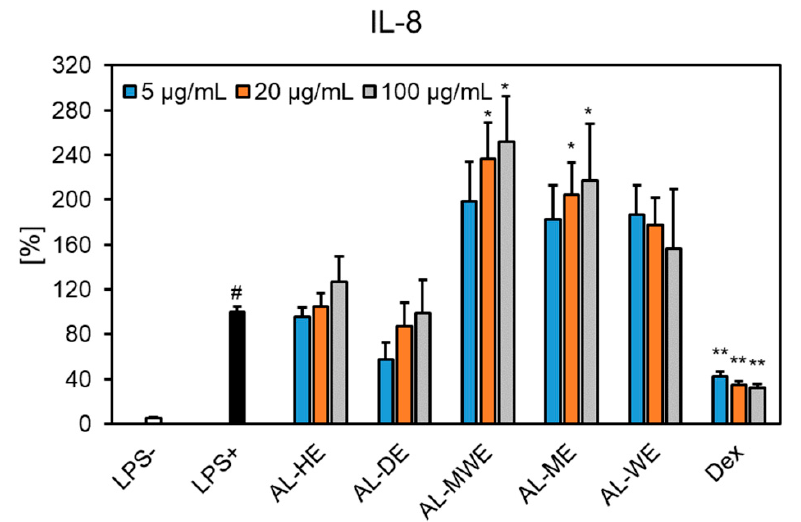
Figure 10. The effects of Artemisia campestris subsp. lednicensis extracts (5–100 µ g/mL) and dexamethasone (Dex) (0.01–1 µ M) on IL-8 production in LPS-stimulated (100 ng/mL) neutrophils. Results are presented as the mean ± SEM of three separate experiments performed with cells isolated from six independent donors; # p < 0.001 vs. non-stimulated control (LPS-); * p < 0.05; ** p < 0.001 vs. stimulated control (LPS+). Abbreviations: AL-HE, A. campestris subsp. lednicensis hexane extract; AL-DE, A. campestris subsp. lednicensis dichloromethane extract; AL-ME, A. campestris subsp. lednicensis methanol extract; AL-MWE, A. campestris subsp. lednicensis 50% methanol extract; AL-WE, A. campestris subsp. lednicensis water extract; LPS, lipopolysaccharide.